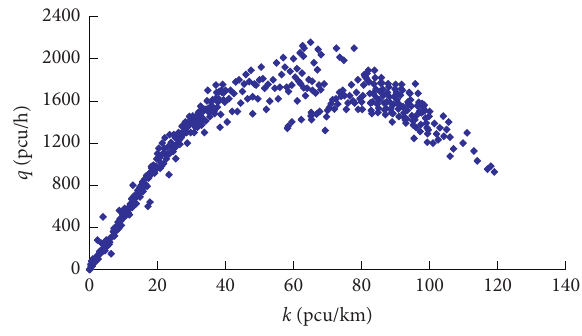
Figure 2: Flow-density scatter